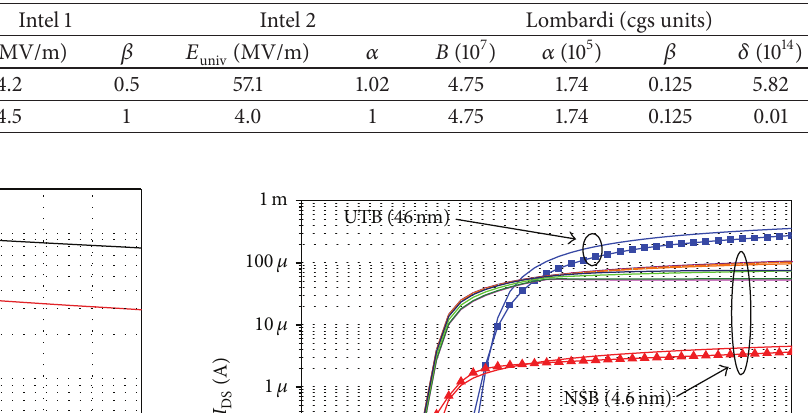
Table 2: Parameter(s) value(s) of the respective standard electron mobility models. Changed value(s) correspond to a nonphysical behavior of the simulated transfer characteristics (i.e., null transconductance).